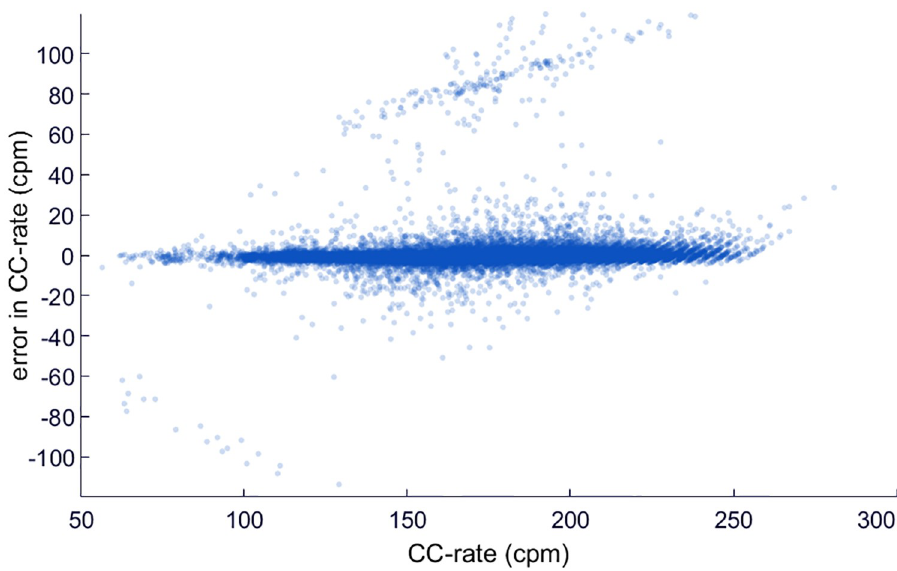
Fig 4. Error in the estimation of compression rate. Scatter plot representing the error in cpm with respect to the reference value for the validation subset.